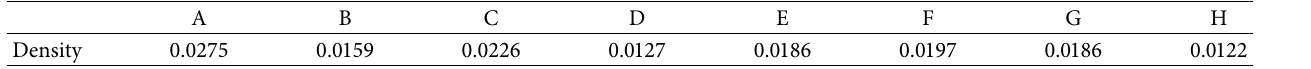
Table 8: Social network density of professional athletes.